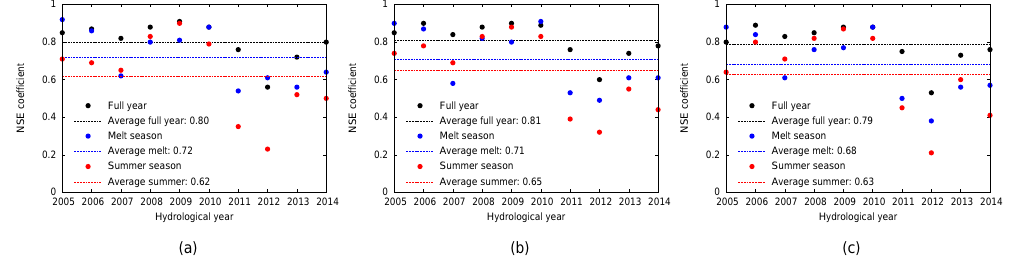
Figure 10. NSE coefficients for simulated daily streamflow for the outlet of the Dischmabach, using the 2cm (a) , 30cm (b) or 60cm (c) water fluxes in the soil layers.